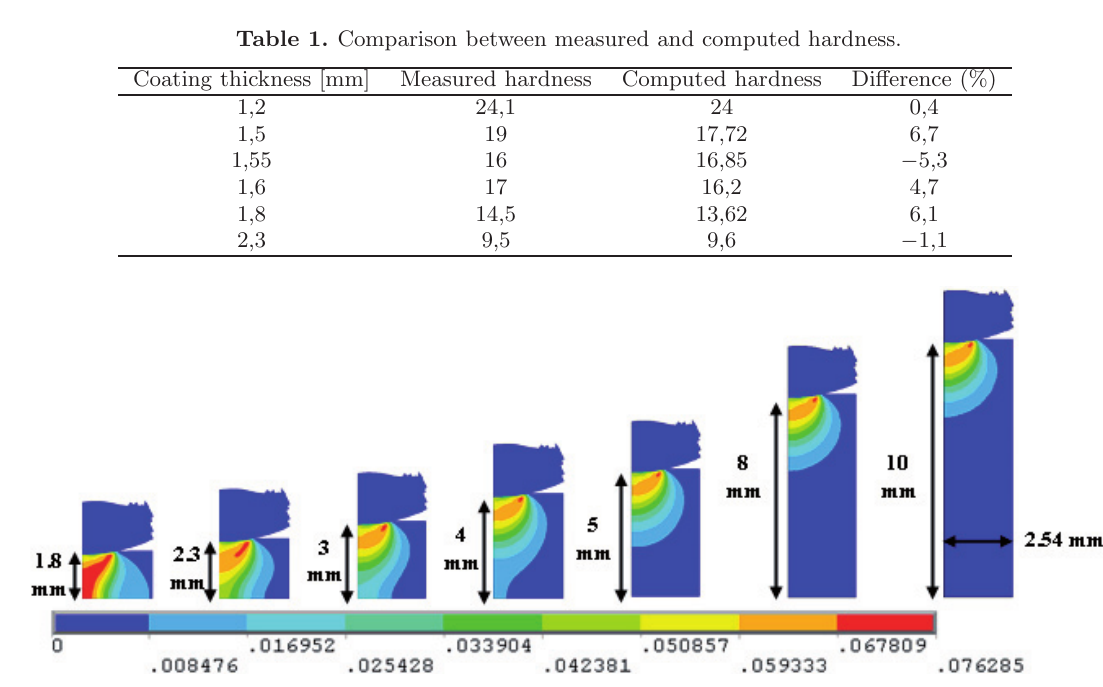
Fig. 12. Von Mises plastic strain component for various thicknesses.